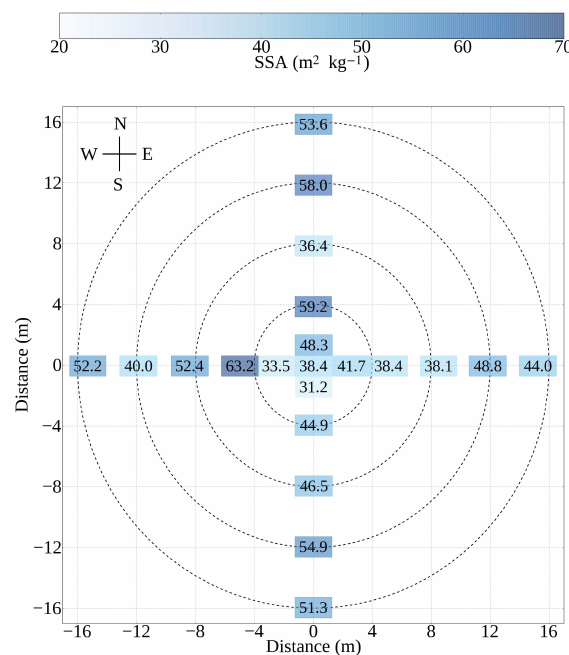
Fig. 7. Spatial variability of SSA in the top 1cm, measured during the survey of 15